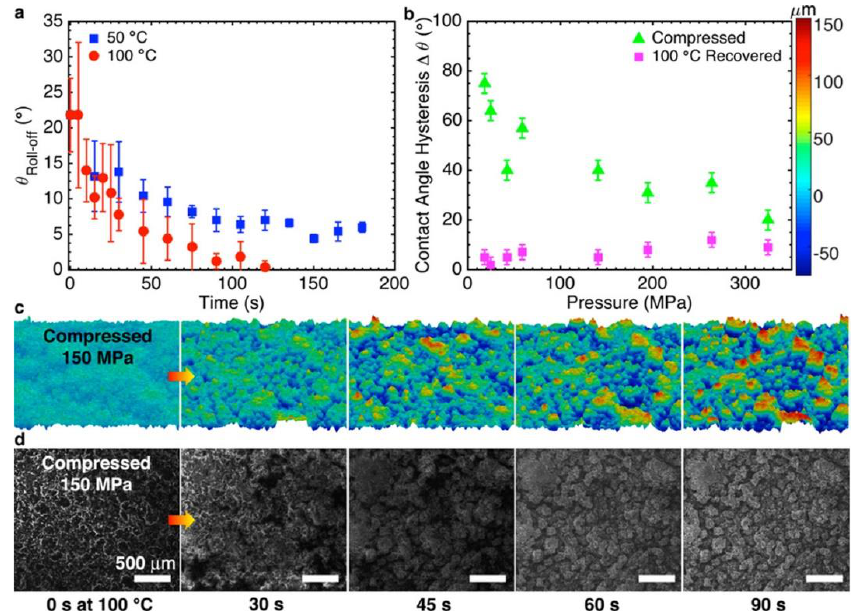
Figure 4. Texture recovery of FPU/FD-POSS coatings ( a ) self-healing as a function of time and temperature, after 1000 Taber abrasion cycles. ( b ) contact angle hysteresis for the coatings before and after thermal recovery from compression, as a function of the compressive load. ( c ) height maps of the coatings after 150 MPa compression, as a function of recovery time at 100 ◦ C ( d ). Reprinted with permission from ACS Appl. Mater. Interfaces 2017, 9 , 11212 − 11223. Ref. [66] Copyright (2017) American Chemical Society.